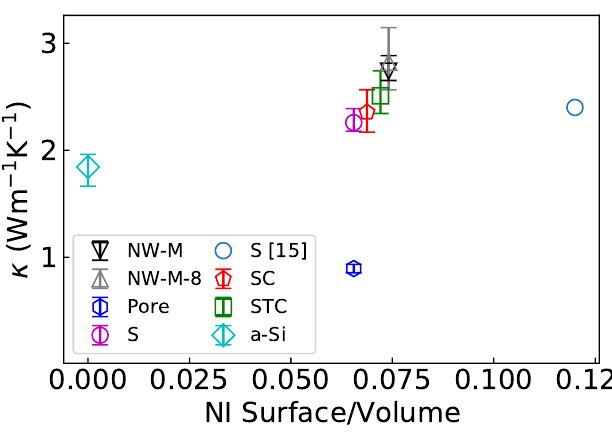
Figure 7. Thermal conductivity estimated with EMD for the studied configurations, as a function of their surface to volume ratio. S [15] refers to the results of Tlili et al. with the same crystalline volume fraction and NW-M-8 refers to a cube constituted by a 2 × 2 × 2 grid of the configuration NW-M. The κ computed for bulk a-Si through EMD is 1.9 W m − 1 K − 1 , which is close to